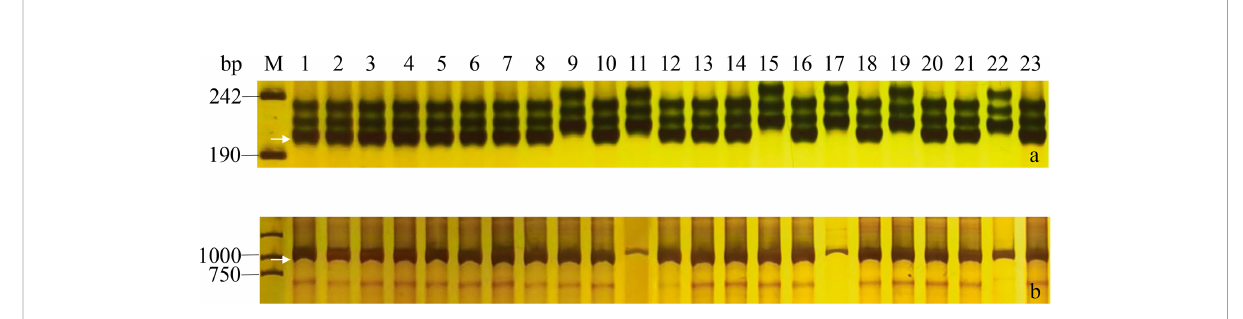
FIGURE 2 PCR ampli fi cations of speci fi c markers GWM261 for Rht8 (A) and Intr1/D for vrn-D1 (B) in 23 Yannong series wheat cultivars/lines. M, pUC19 (A) / DL2000 (B) ; Lane 1-23: Yannong 30, Yannong 37, Yannong 377, Yannong 15, Yannong 17, Yannong 23, Yannong 24, Yannong 31, Yannong 161,